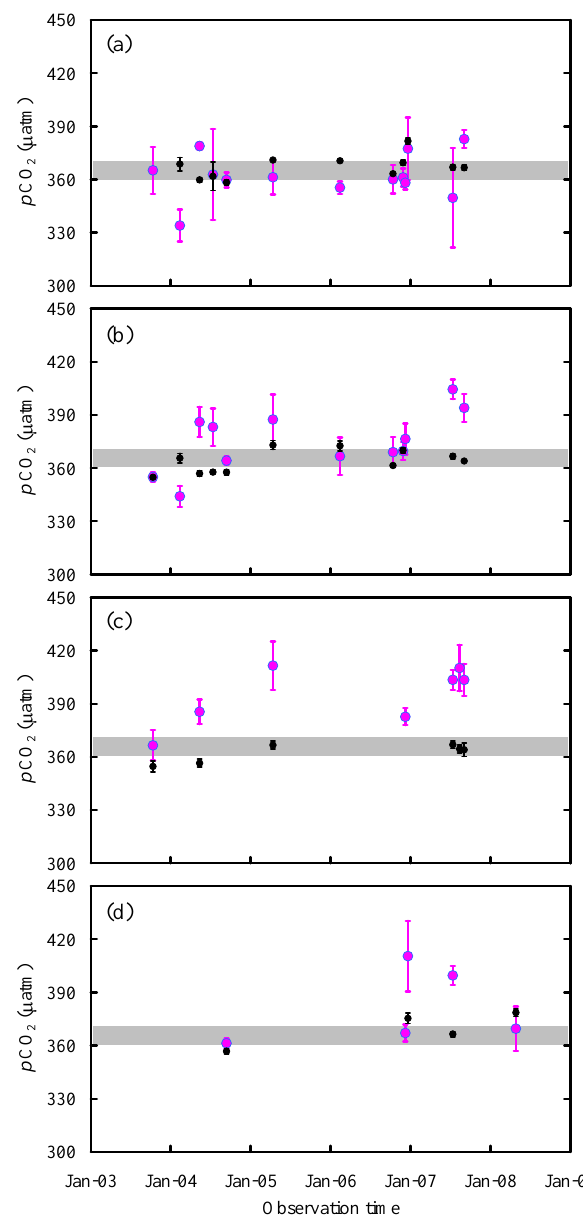
Fig. 7. Time series of field-measured sea surface p CO 2 (pink dots) and atmospheric p CO 2 (dark dots) for flux estimation in domain A (a) , in domain B (b) , in domain C (c) , and in domain D (d) based on data presented in Tables 3, 4, 5, and 6. Data are shown as mean ± standard deviation. The range of 360 to 370µatm is marked by the grey